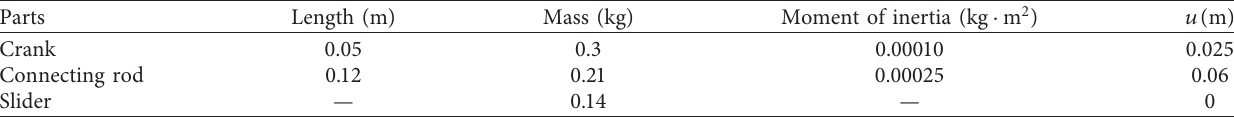
Table 1: Geometric and inertia properties of original slider-crank mechanism.